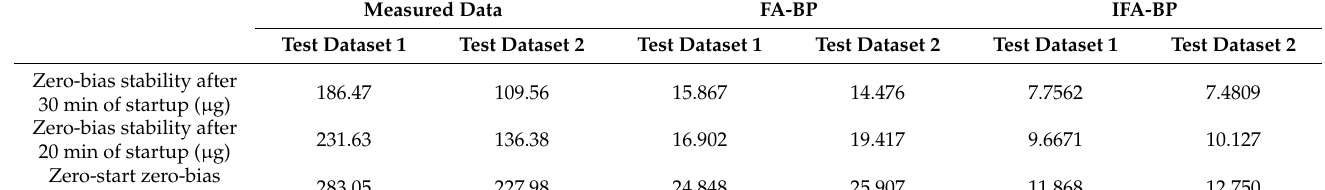
Table 1. Zero-bias stability at room temperature before and after compensation.